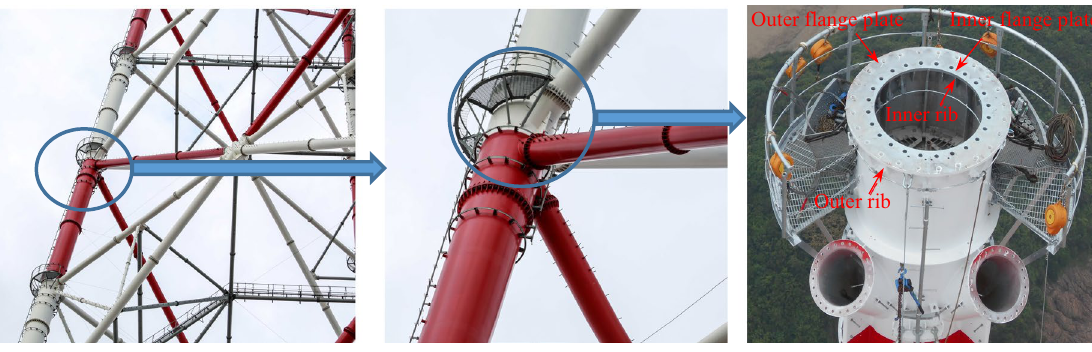
Figure 1. Inner-outer flange in a tubular transmission